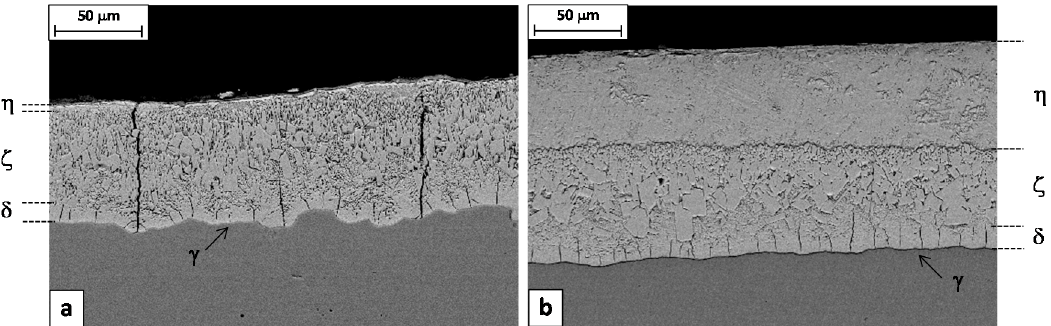
Figure 6. SEM images of Steel 1 rod longitudinal sections.